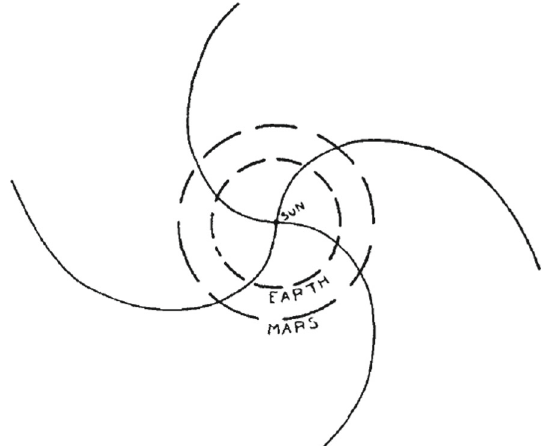
Fig. 3 Solar equatorial interplanetary magnetic field lines carried by outward-streaming plasma with velocity 10 3 km/s. Image reproduced with permission from Parker (1958), copyright by